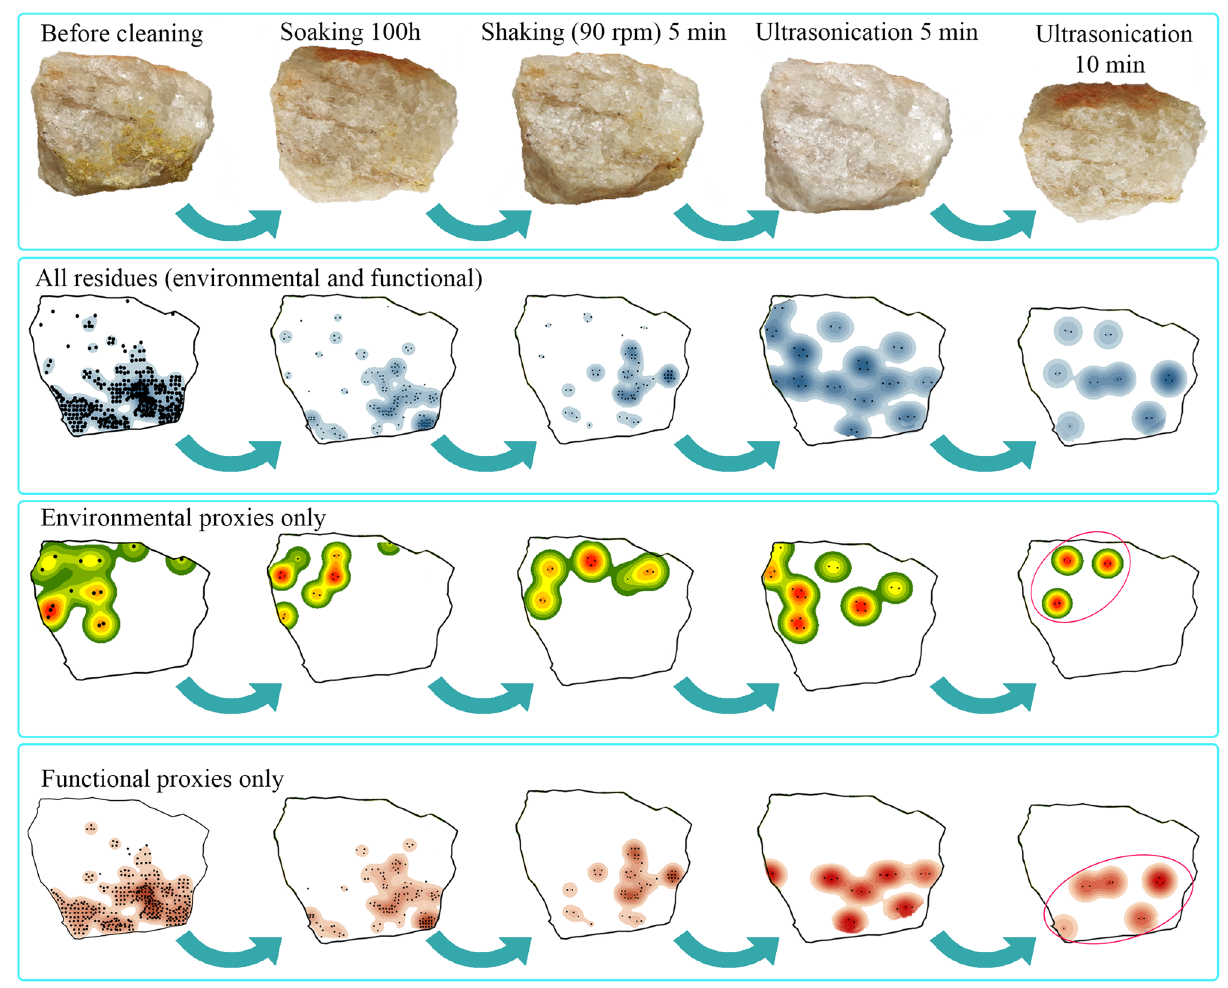
Figure 4. Impact of laboratory cleaning on spatial distribution of residues:natural and anthropogenic